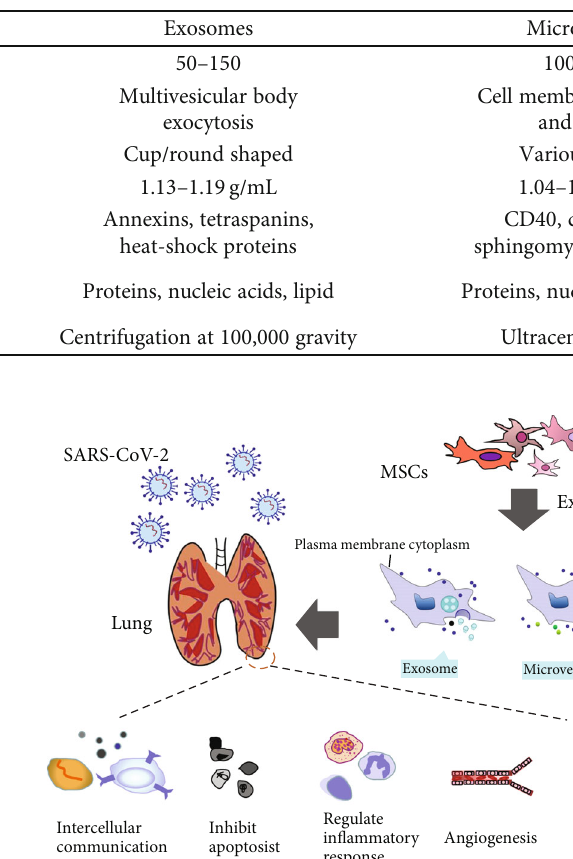
Table 2: The characteristics and categories of EVs.